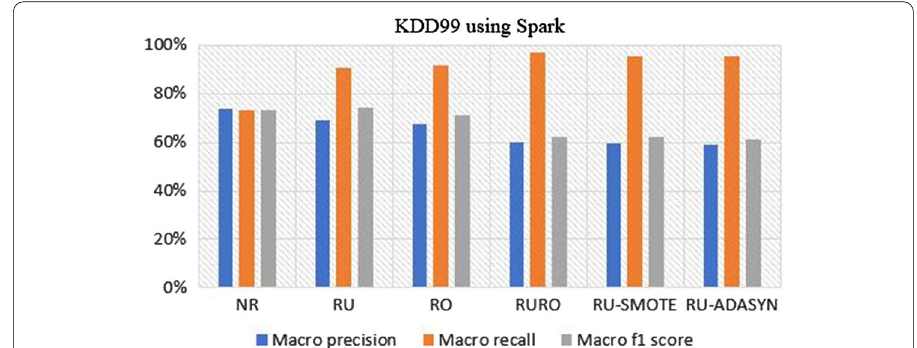
Fig. 6 ANN classification results for KDD99 on AWS with Spark for various resampling methods